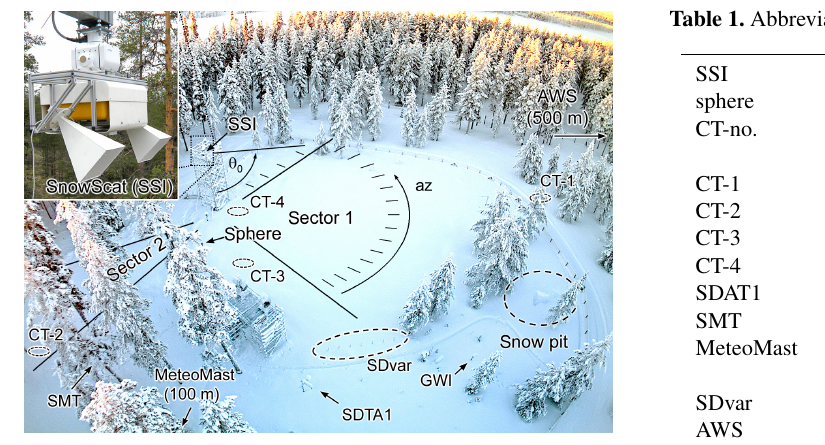
Figure 5. The radar data and meteorological measurements were acquired on the above shown test site near the town of Sodankylä, Finland. The SnowScat instrument (SSI; inset) was mounted on a 9m high tower. The reference target (sphere) used for calibration can be located behind a tree. The SSI scanned sectors 1 and 2 with different azimuth (az) and incidence angles θ 0 . The meteorological sensors SMT, MeteoMast, SDAT1, GWI, and AWS are specified in Table 1. Snow profiles were taken at CT-1 to CT-4 for analysis by computer tomography. Snow density was measured in the snow pit, with the Gamma Water Instrument (GWI), and was also derived from the snow water equivalent (SWE) determined by the SSI as described in Leinss et al. (2015). The variability of snow depth was measured with seven sticks inside the ellipse “SDvar”.